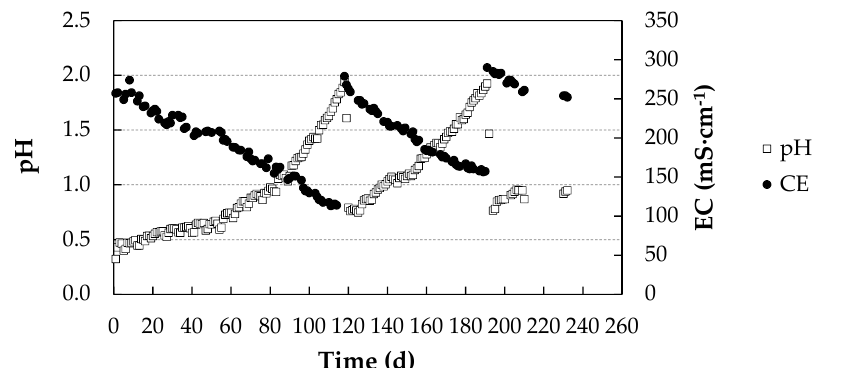
Figure 4. pH and electrical conductivity (EC) values of the acidic capture solution during the experimental period at the pig farm.